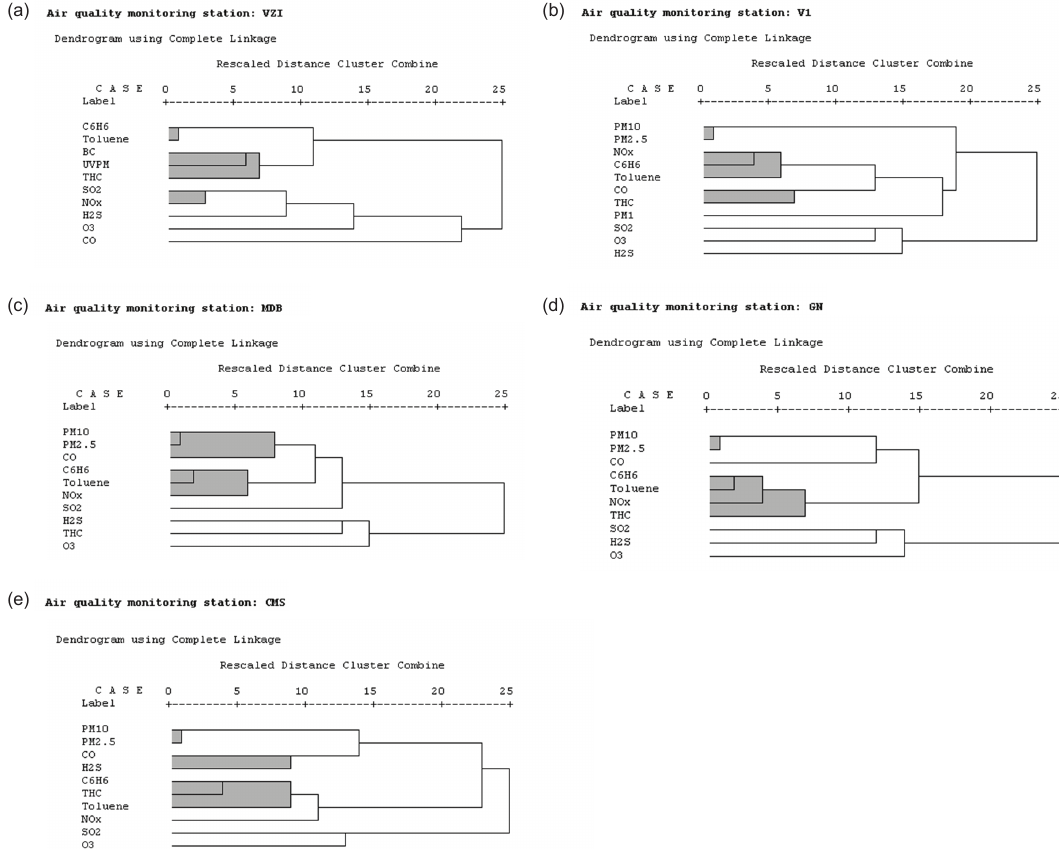
Figure 6. Dendrograms obtained by applying the furthest-neighbour clustering method to the pollutant concentration data recorded at (a) VZI monitoring site, (b) V1 monitoring site, (c) MDB monitoring site, (d) GN monitoring site and (e) CMS monitoring site. The clusters are shown in